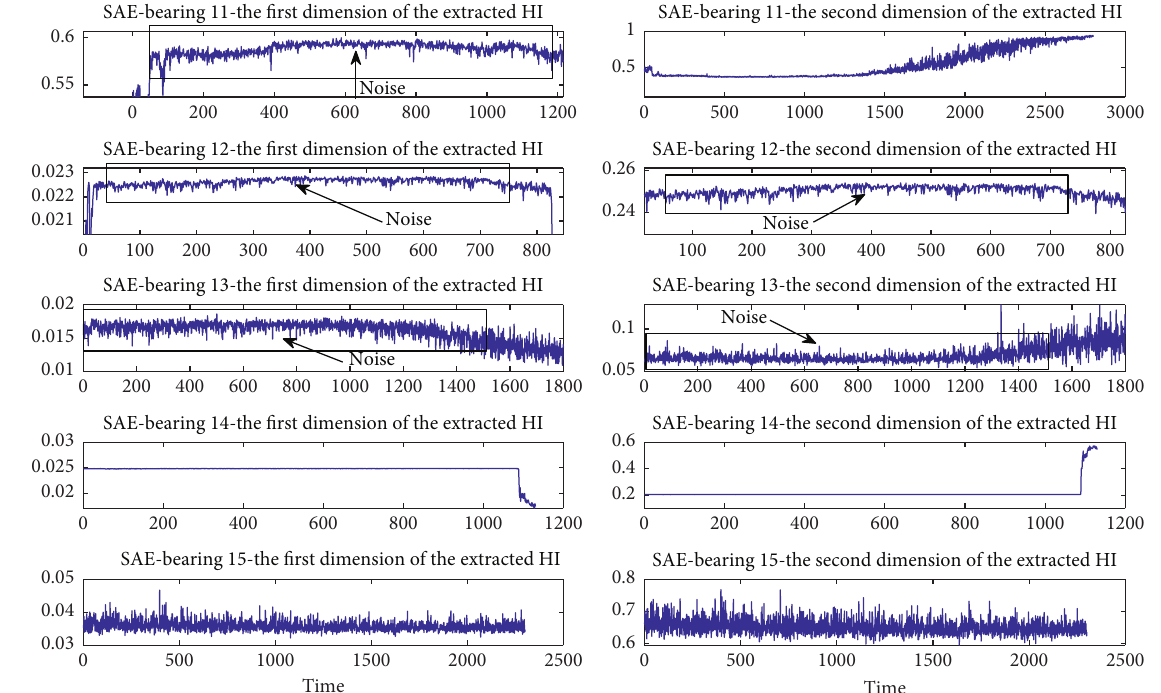
Figure 10: The extracted two-dimensional degradation features for bearings 11–15 through the final hidden layer by using the SAE. SDAE-bearing 11-the first dimension of the extracted HI 6.26.46.66.877.27.4